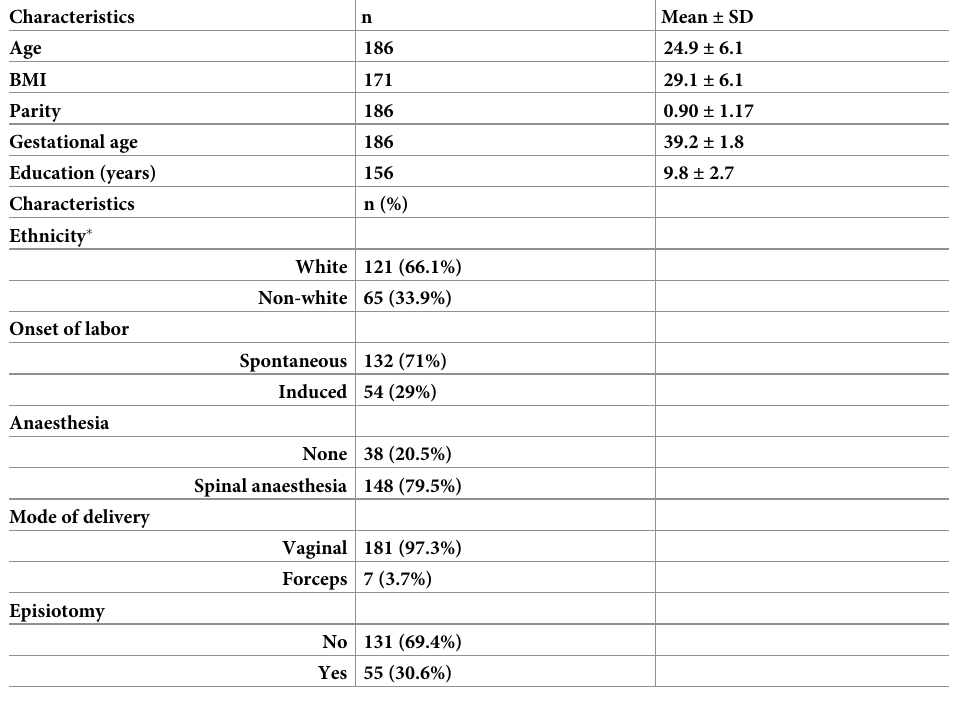
Table 1. Sociodemographic and obstetric characteristics of women.